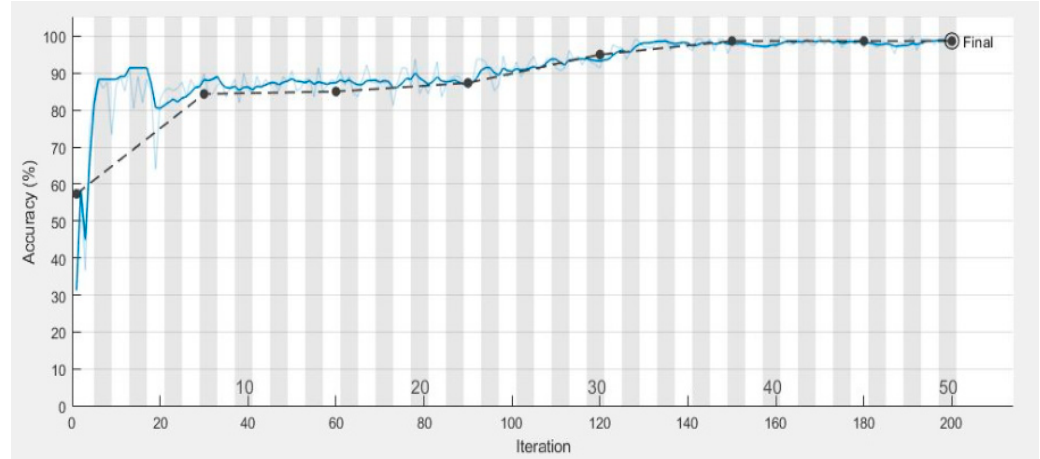
Figure 7. Graphical Representation of Validation and Training Accuracy over the various number of iterations.